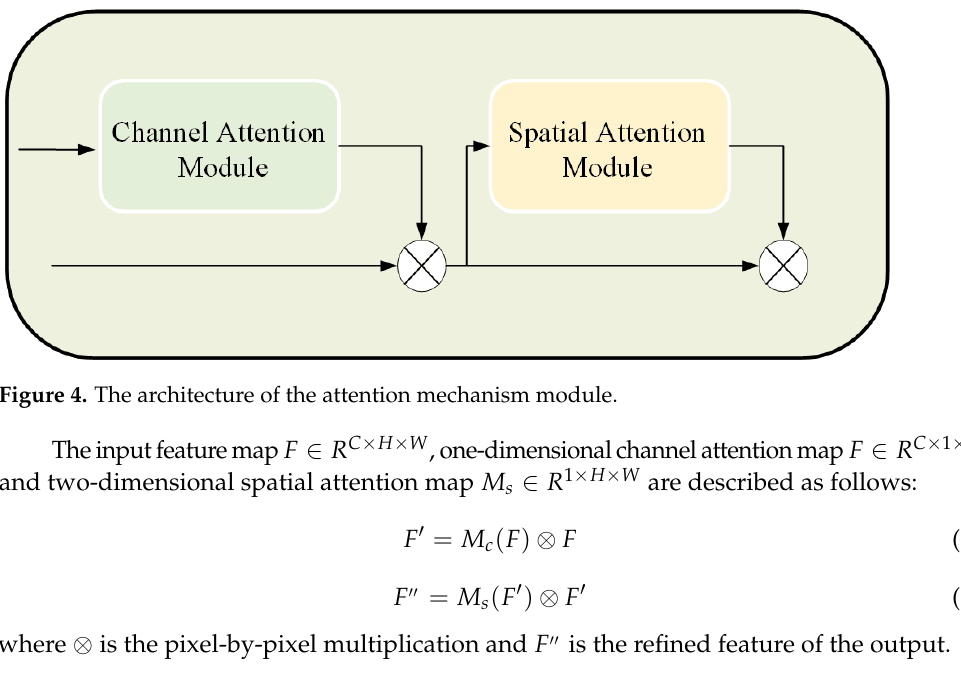
Figure 3. The architecture of the residual network.